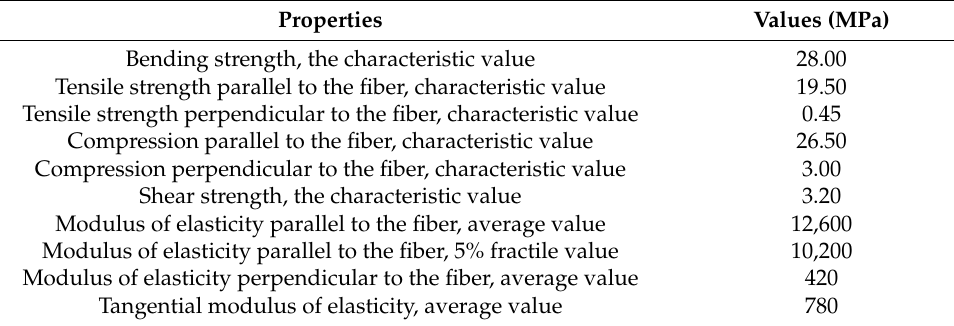
Table 1. Manufacturer specifications regarding the strength and rigidity properties of laminated timber. Adapted from Luca and Marano [14].